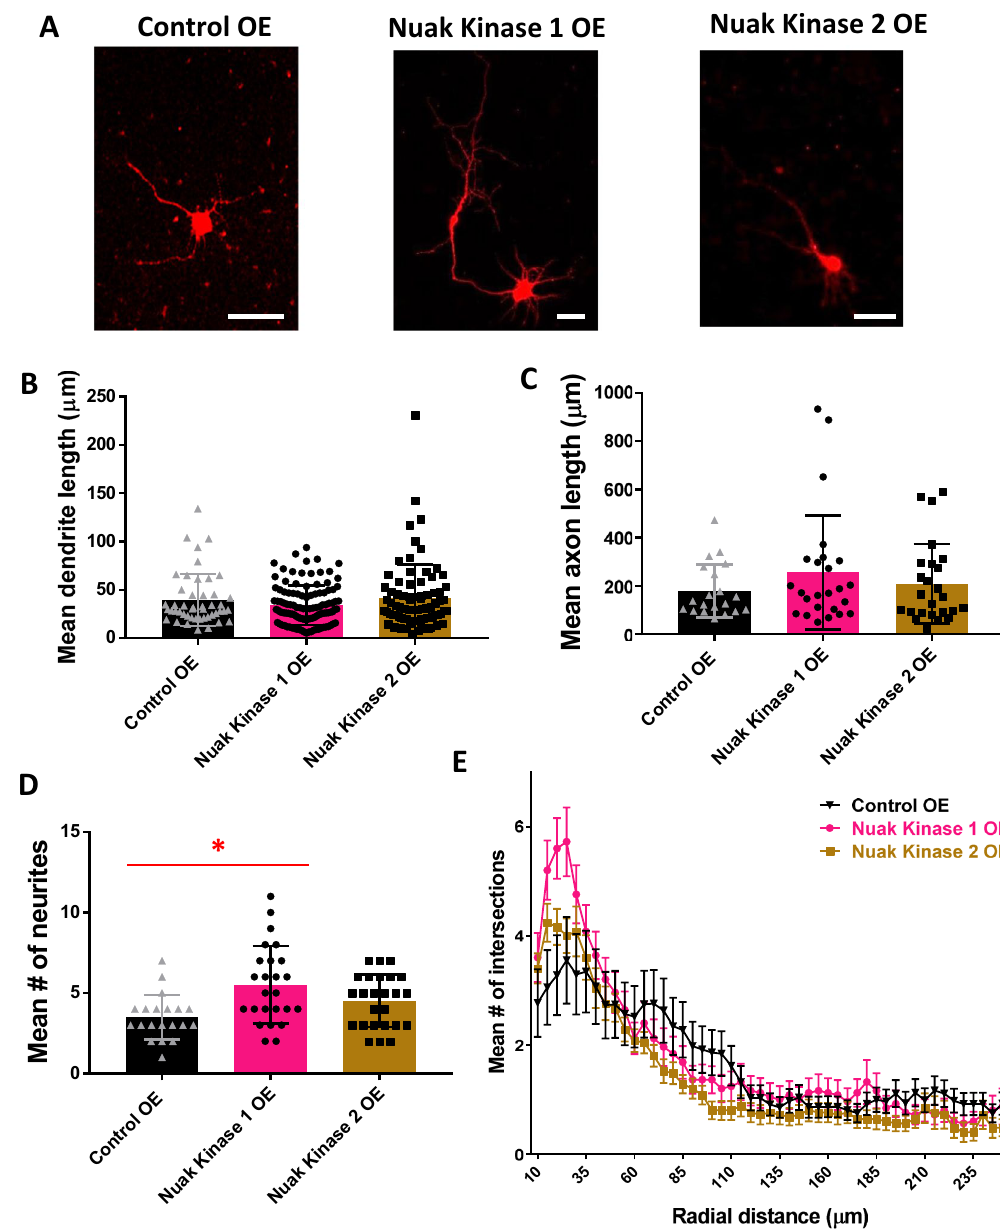
Figure 5. Overexpression of Nuak kinases 1 and 2 in primary cortical neurons suggests roles for Nuak Kinase 1 in neurite initiation and dendritic branching. ( A ) Primary cortical mouse neurons transfected with mRFP at 48 h after re-plating, scale bars 50 µm. ( B ) One-way ANOVA determined there was no statistically significant difference in length of neurites likely to become dendrites [F(2,234) = 1.904, p = 0.151]. There